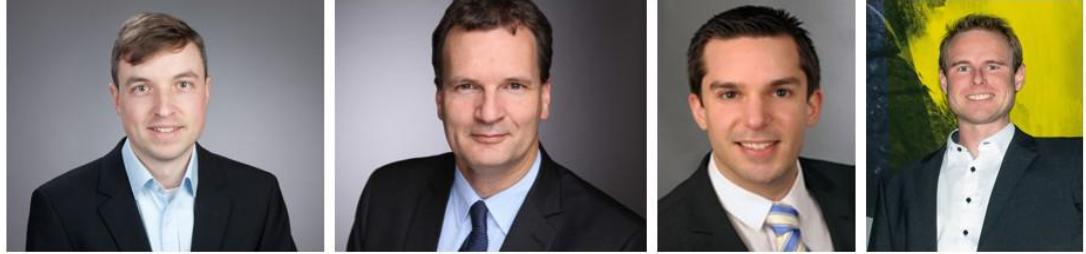
Figure 3. Dr. Becker’s research group (From left: Raphael Wegmann, Dirk Uwe Sauer, homas Nemeth, Jan Becker).